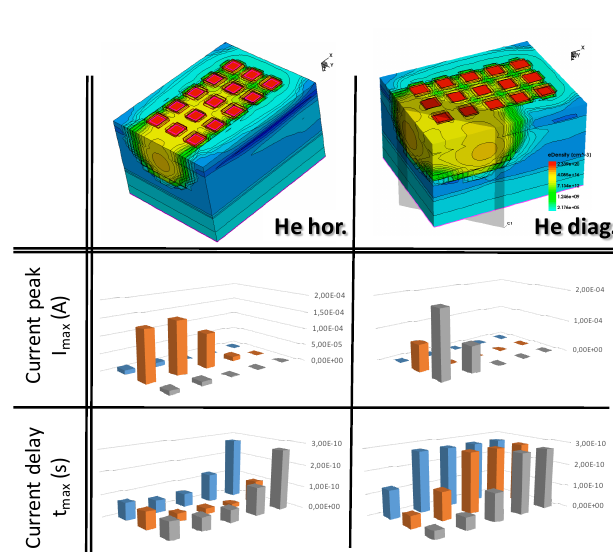
Fig. 12. Variation of the current peak and current delay at the output of the 15 pixels for the alpha generated horizontally and diagonally.